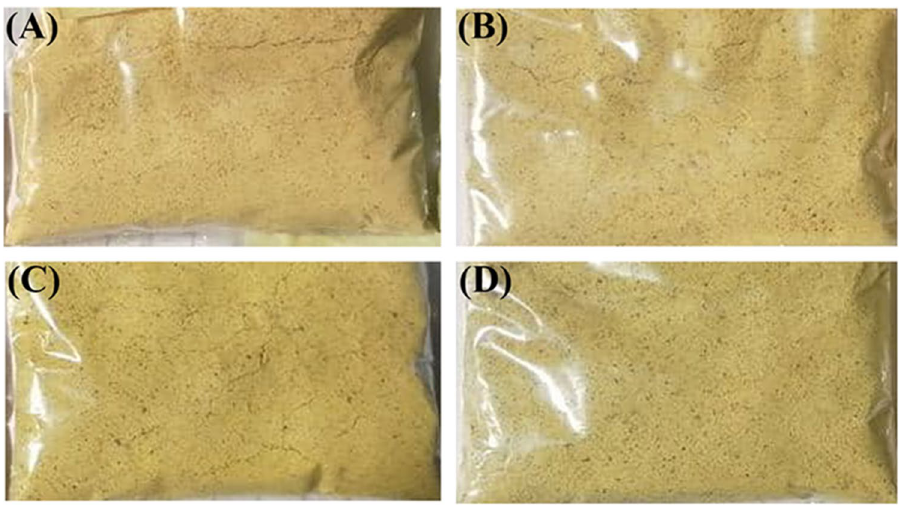
Figure 2. Dry soup prepared by different % of DGCPp. ( A ), control; ( B ), 5% DGCPp; C, 10% DGCPp; D, 15% DGCPp.